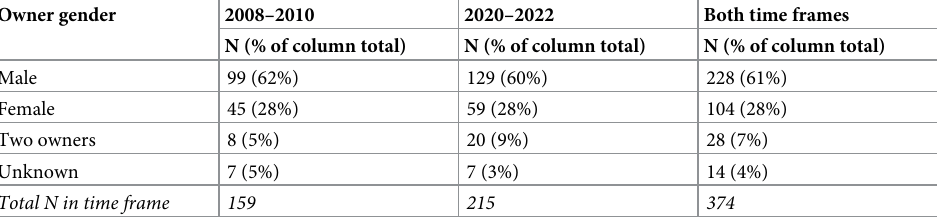
Table 2. Descriptive data on gender of owners of confiscated dogs. Owner gender as count and as % of column total for a first time frame (2008–2010), a second time frame (2020-mid-May 2022) and overall for both time frames, with no identified significant difference between the two time frames (P � 0.05), for owners of 374 confiscated